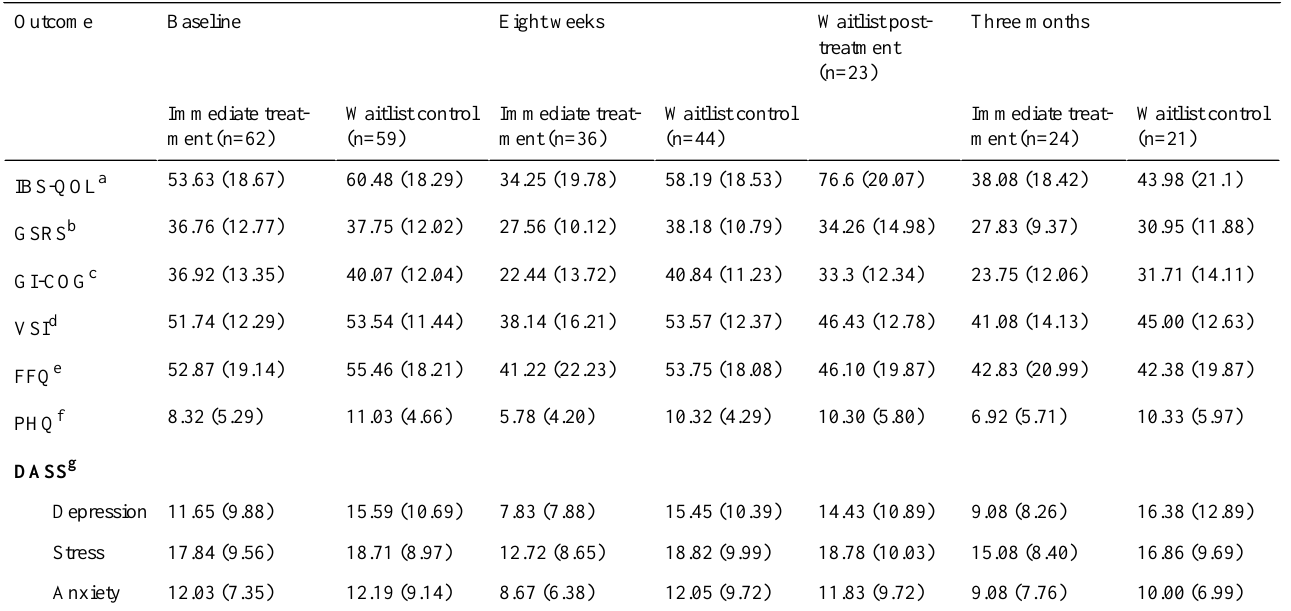
Table 1. Mean (SD) outcome measures across the trial for the immediate treatment and waitlist control groups.